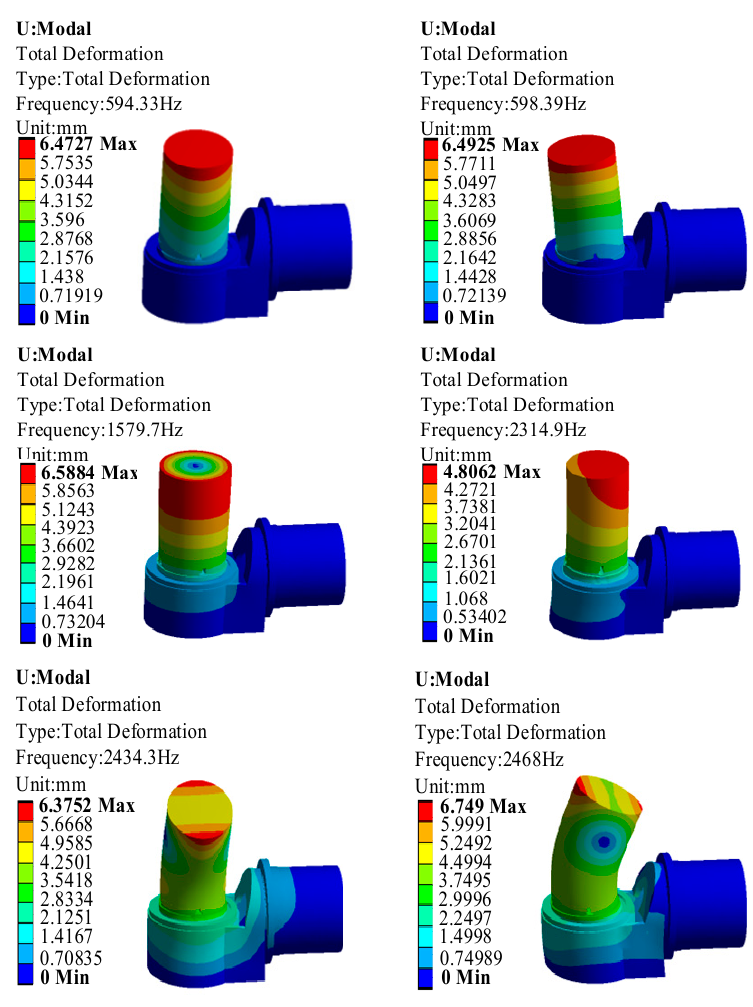
Figure 14. Nephogram of the first six vibration modes under milling conditions. Table 8. The first six vibration modes and natural frequencies of direct-drive turntable under milling conditions.